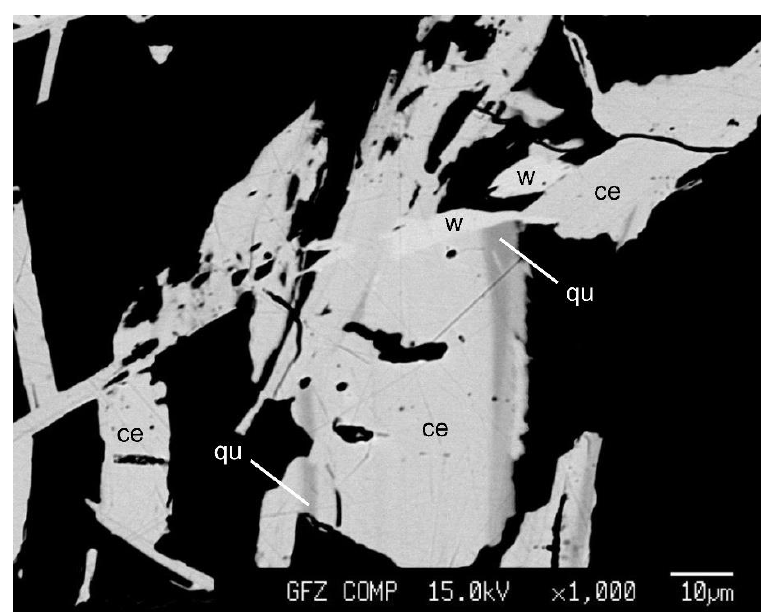
Figure 3. BSE image of type-II cerromojonite (ce) intergrown with quijarroite (qu) and watkinsonite (w).